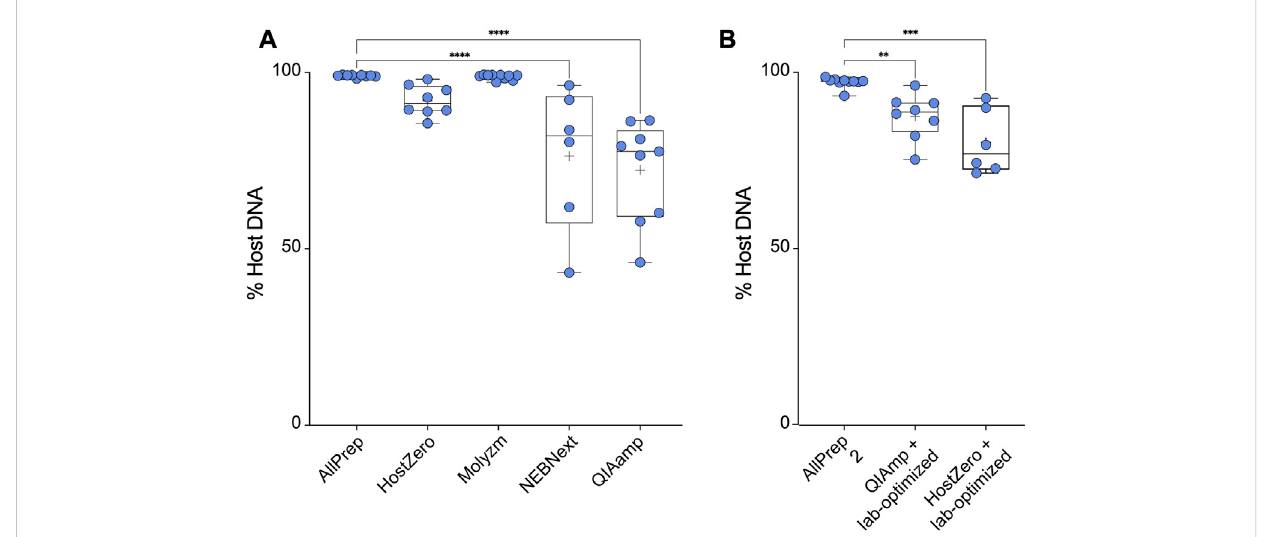
FIGURE 2 Microbial enrichment kits reduce host DNA in extracted DNA samples. (A) Percentage of host DNA in samples prepared using different microbiome DNA enrichment methods was compared to the percentage of host DNA extracted using a total DNA extraction kit (AllPrep). (B) As in (A) , only the methods of the indicated microbiome DNA enrichment kits were modi fi ed as described by Bruggeling et al. Asterisks for p -values: * p < 0.05, ** p < 0.01, *** p < 0.001and**** p < 0.001.TheCohen ’